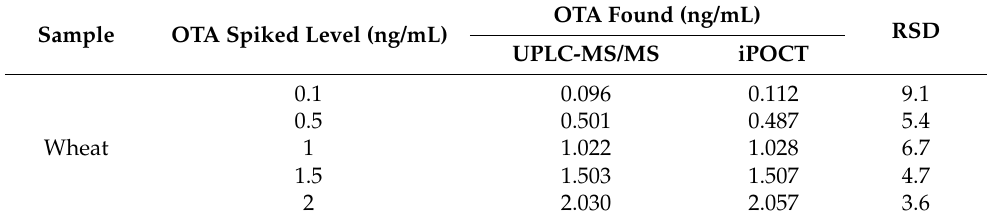
Table 1. Comparison between this proposed iPOCT and UPLC-MS/MS method using wheat. Sample